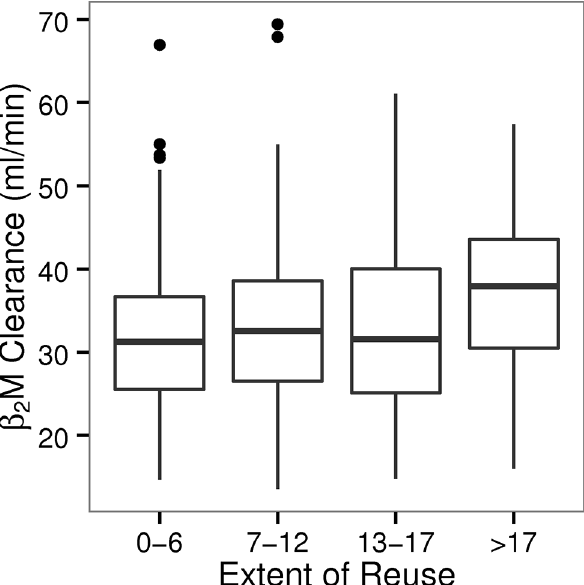
Fig 2. Distribution of predicted β 2M clearance across quartiles of membrane reuse in HEMO. Controlling the extent of reuse by the HEMO study protocol yielded average clearances that were equivalent across reuse quartiles in patients receiving HF dialysis. Average β 2M clearance by HF dialyzers in the 2nd to 4th reuse quartile, was 1.26 ± 1.02 (p = 0.21), 1.47 ± 1.00 (p = 0.14) and 5.41 ± 1.03 (p < 0.001) ml/min higher relative to the first quartile (31.8 ± 0.69 ml/min). concentration of 4.03 β 2M ± 1.08 mg/l (p < 0.001) relative to non-reused HF dialysis in these